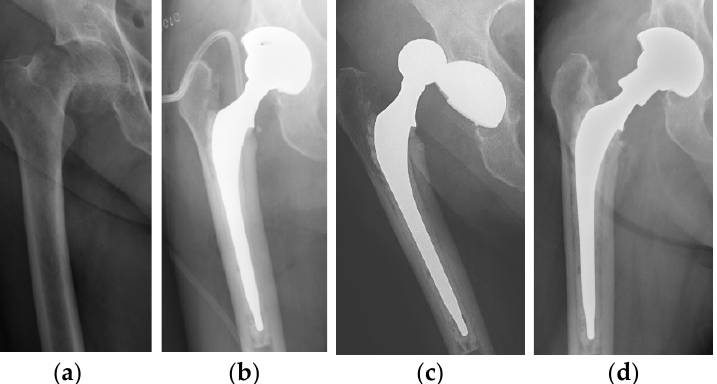
Figure 1. ( a ) Displaced intracapsular fracture (Garden-type IV) of the right femoral neck in a 79-year-old woman. ( b ) Postoperative radiograph after surgical treatment with a conventional THA. ( c ) Prosthesis dislocation 3 weeks after surgery. ( d ) Radiograph after implantation of a neck adaptor to increase length and lateral offset.